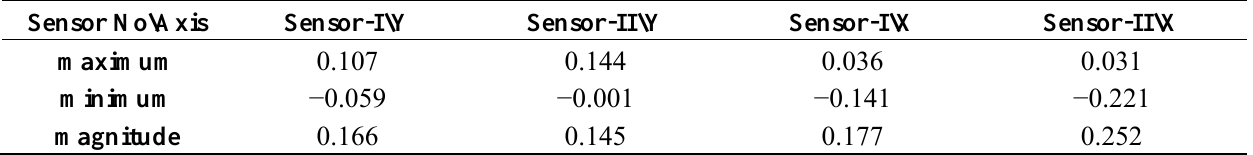
Table 2. Statistics of the tall building inclinations in